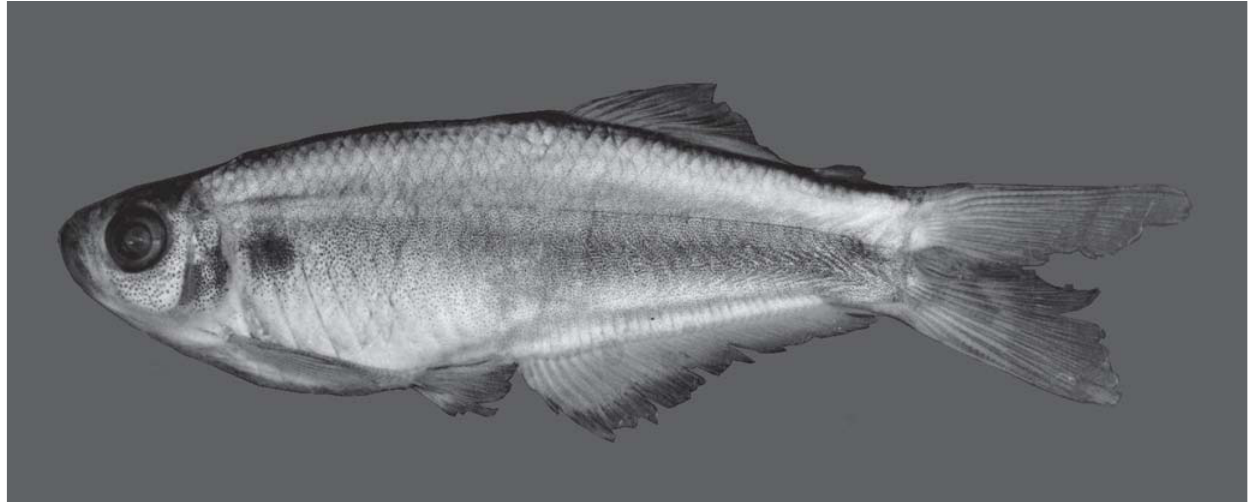
Fig. 79. Mimagoniates microlepis , adult male, MZUSP 14668, 40.7 mm SL, Rio de Janeiro State, rio Guapiaçu, Cachoeiras de Macacu.